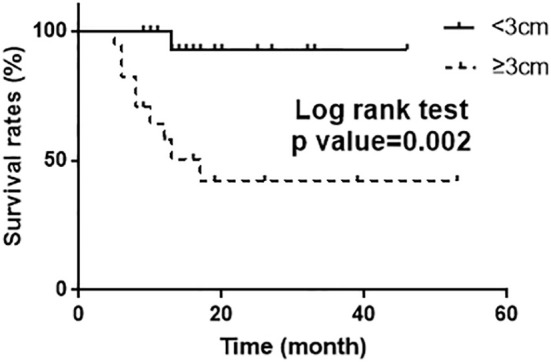
Kaplan–Meier curve of PFS (log rank test p =0.002) according to the parametrial extension widths.